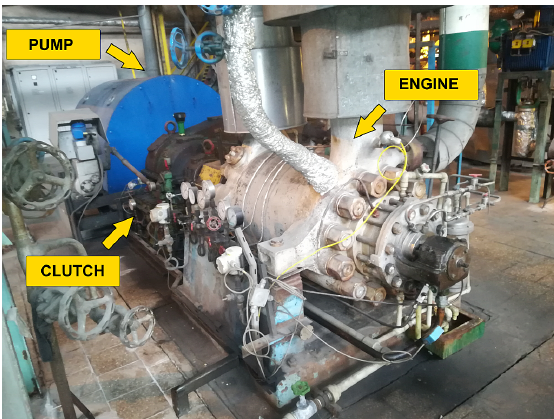
Figure 2. Picture of three stage pump unit with the measuring